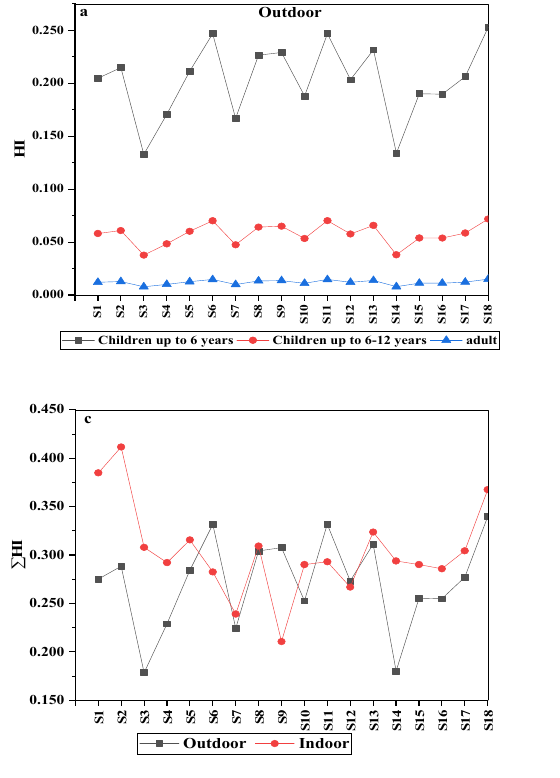
Figure 5. The hazard index (HI) average in ( a ) outdoor dust samples and ( b ) indoor dust samples, and the ( c ) total hazard index for Σ human categories in outdoor and indoor dust samples. The average of HI values in outdoor and indoor dust samples are shown in Figure 6. The average of HI values in outdoor and indoor dust were less than 1, suggesting that there is non-carcinogenic risk. However, the average values of HI in indoor dust were higher than outdoor dust for all human categories.